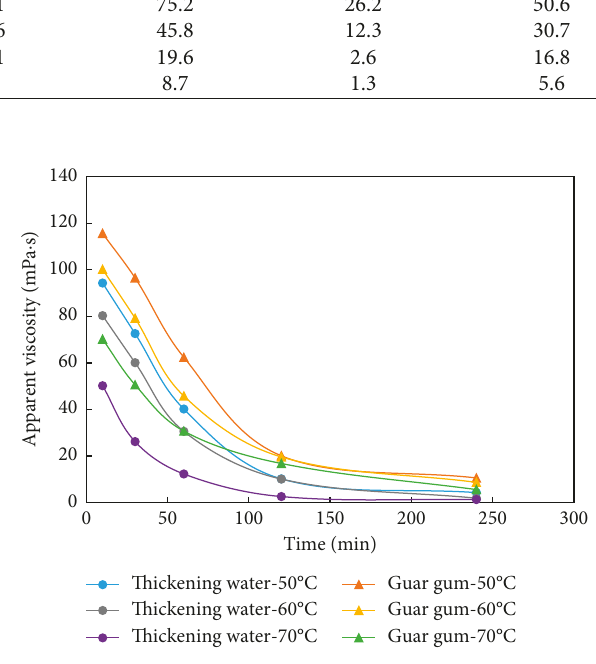
Figure 3: Comparison of gel breaking property of two kinds of fracturing